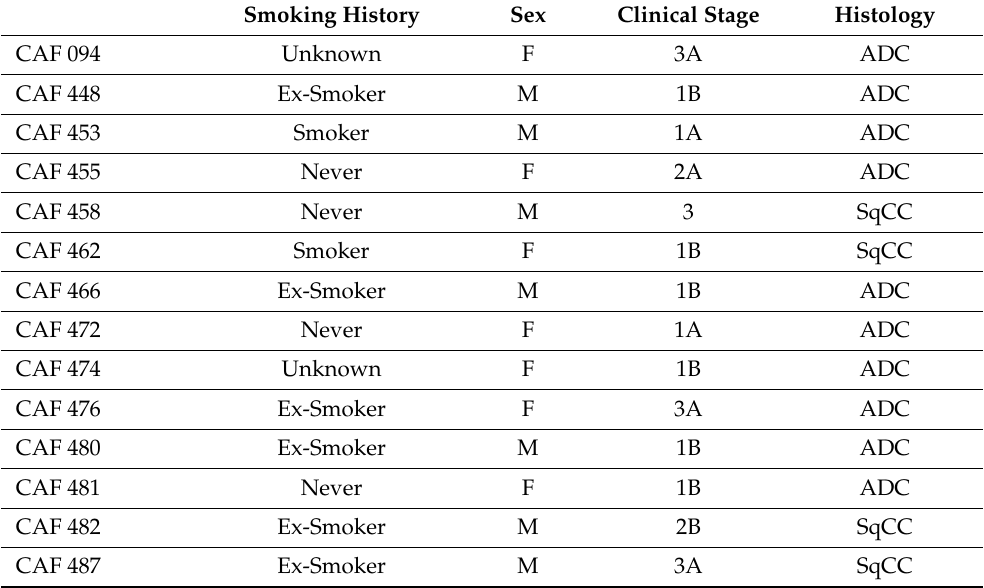
Table 1. Patient demographics, tumor stage and pathological diagnosis for tumors from which CAFs used in this study were isolated. Smoking History Sex Clinical Stage Histology CAF 094 Unknown F 3A ADC